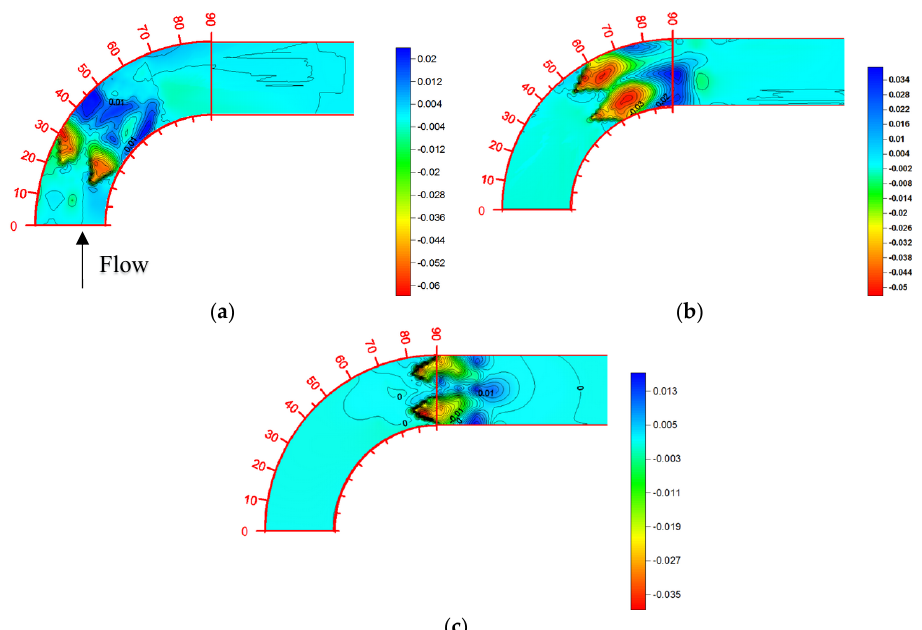
Figure 4. The topography of the bed for a Froude number of 0.17 and W − Weir installation at 30, 60, and 90 degrees (all dimensions in meters). ( a ) Installation angle = 30 degrees. ( b ) Installation angle = 60 degrees. ( c ) Installation angle = 90 degrees.